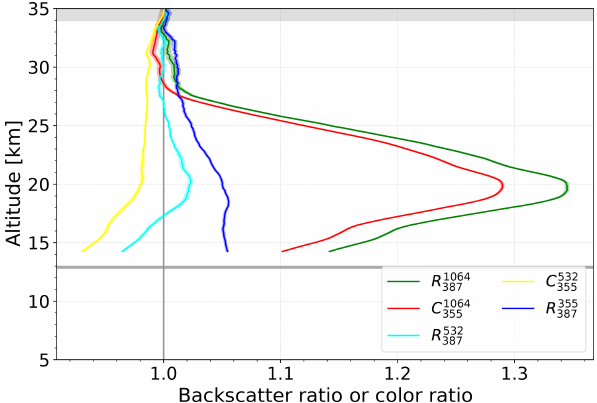
Figure 4. Backscatter ratio and color ratio profiles for a 97h long measurement starting at 07:45UT on 10 October 2015. About 46h were measured with daytime configuration and 51h with nighttime configuration. The gray area at the top indicates part of the normal- ization altitude. Shaded areas around the lines indicate the measure- ment uncertainty. The gray line at 13km indicates the